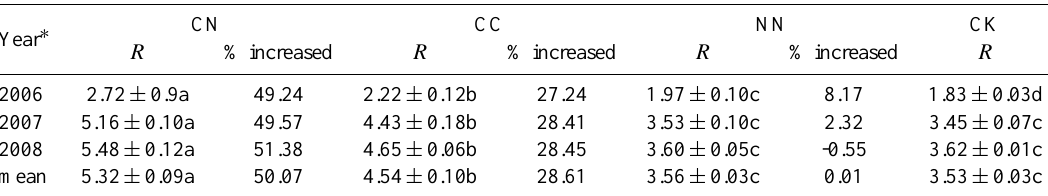
Table 5. Aannual or semiannual soil respiration ( R ) and its % increased for each year of the experiment (mean ± standard deviations). Standard deviation within each treatment showed the dispersion among open-top chambers employed for each treatment. n = 3 for the CN and CC treatments, n = 2 for the NN treatment and CK. R within a row with different lowercase letter have significant treatment differences at α = 0 . 05 level. The treatments are: CK = control, NN = high N, CC = elevated CO 2 , CN = elevated CO 2 + high N. % increased = 100 (( R of each treatment – R of the CK)/ R of the CK) % (in the same year). Unit: kgCO 2 m − 2 6-months − 1 for R in the latter half of 2006; kgCO 2 m − 2 yr − 1 for R in 2007 and